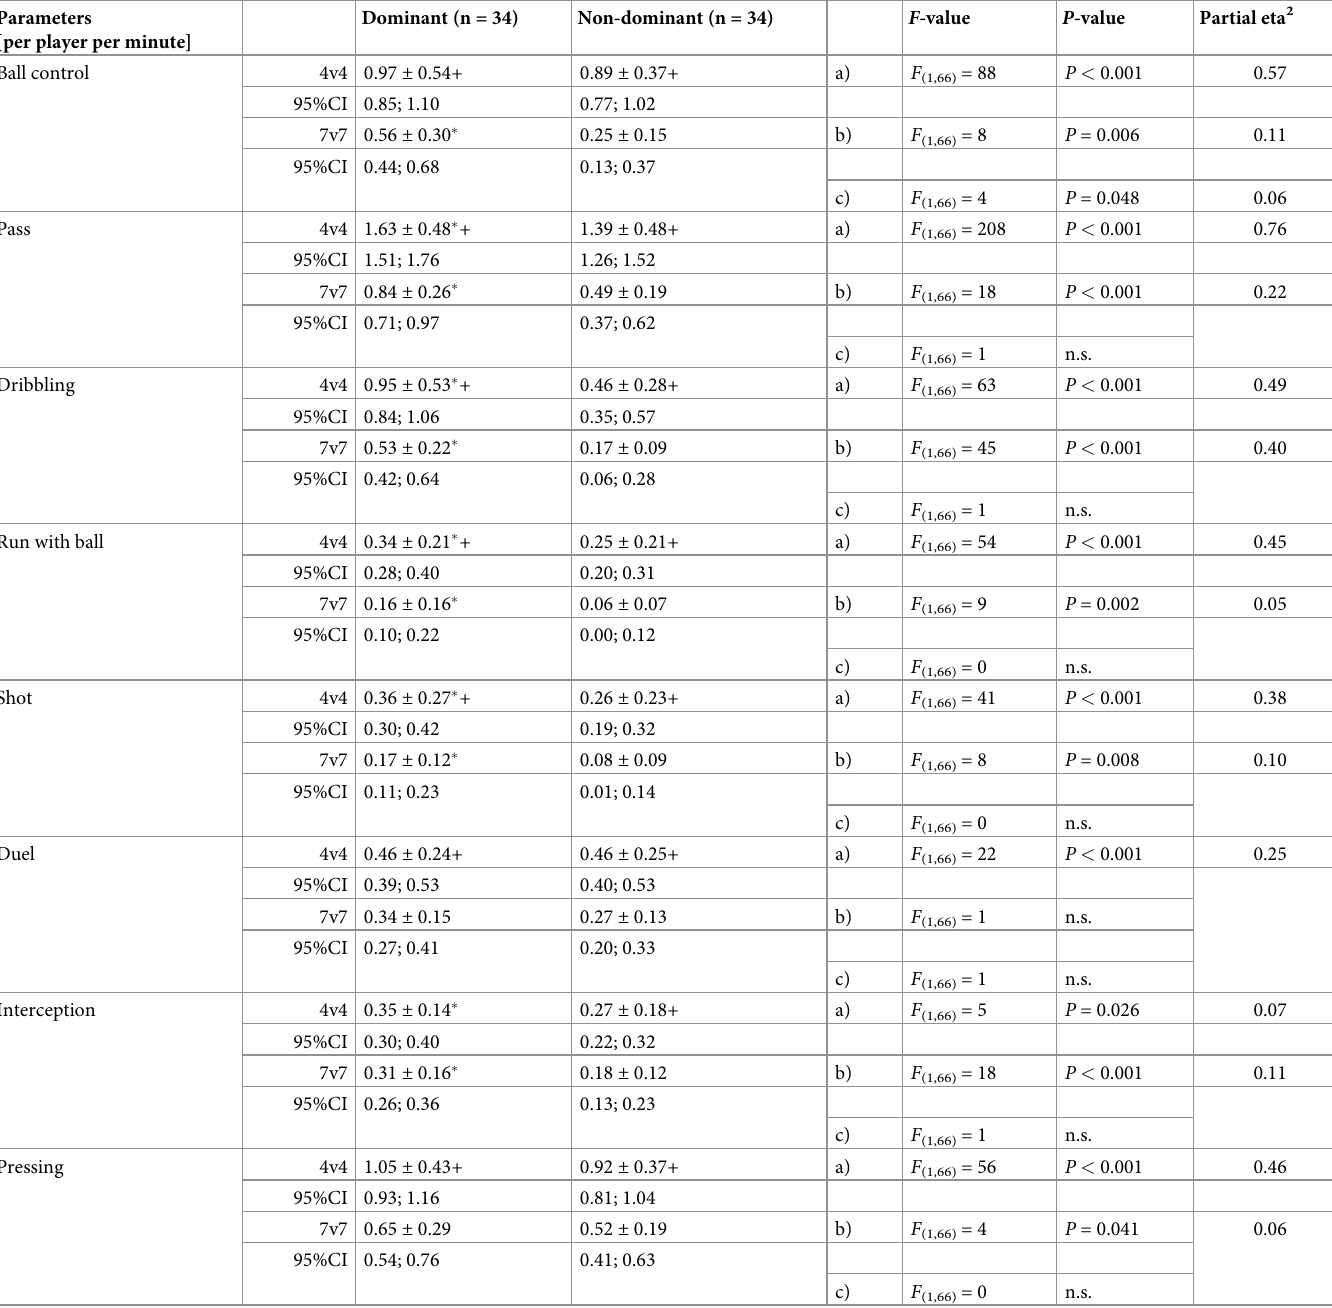
Table 2. The technical and tactical actions of dominant and non-dominant players in 4v4 match format compared to 7v7 (mean ±